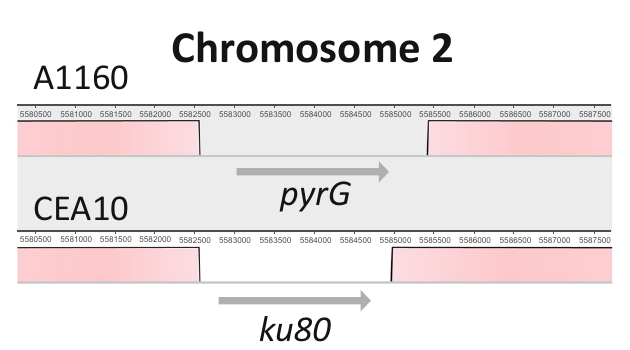
Fig. 3 | Annotation of CEA10 genome showing a detail of chromosome 1 as an example, with a putative centromere. Genomes are annotated in a cursory manner using Exonerate mapping of transcripts and proteins from (Fungi DB) and de novo gene prediction using Genemark EP+and Braker1 and Braker2. Reference anddenovogeneannotationsareshowninbluebars.ThewholeRNAseqcoverage